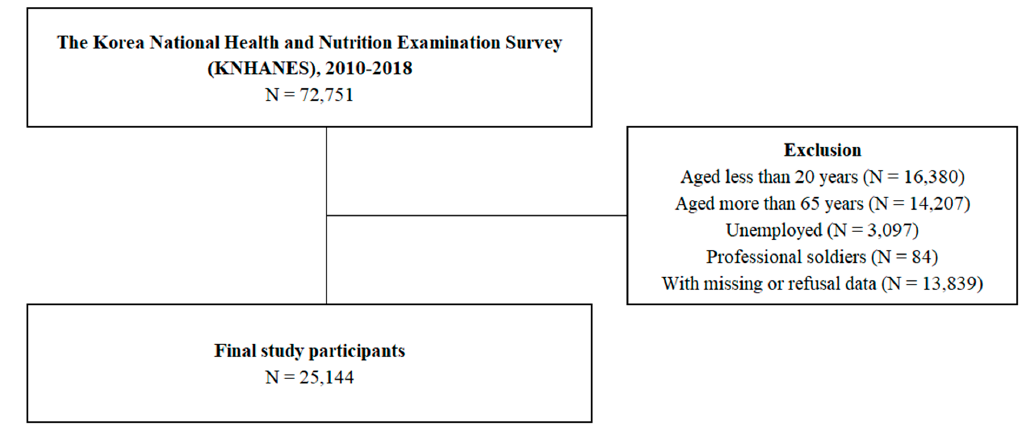
Figure 1. Schematic diagram depicting study population.